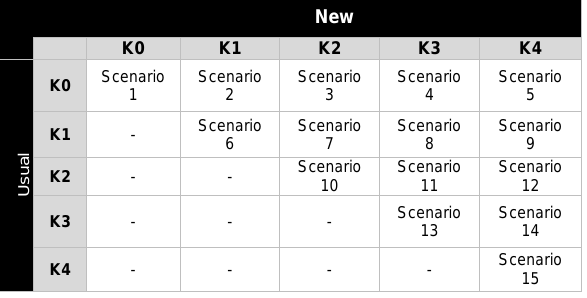
Frossard L. A preliminary cost-utility analysis of the prosthetic care innovations: basic framework. Canadian Prosthetics & Orthotics Journal. 2021; Volume 4, Issue 2, No.10. https://doi.org/10.33137/cpoj.v4i2.36365